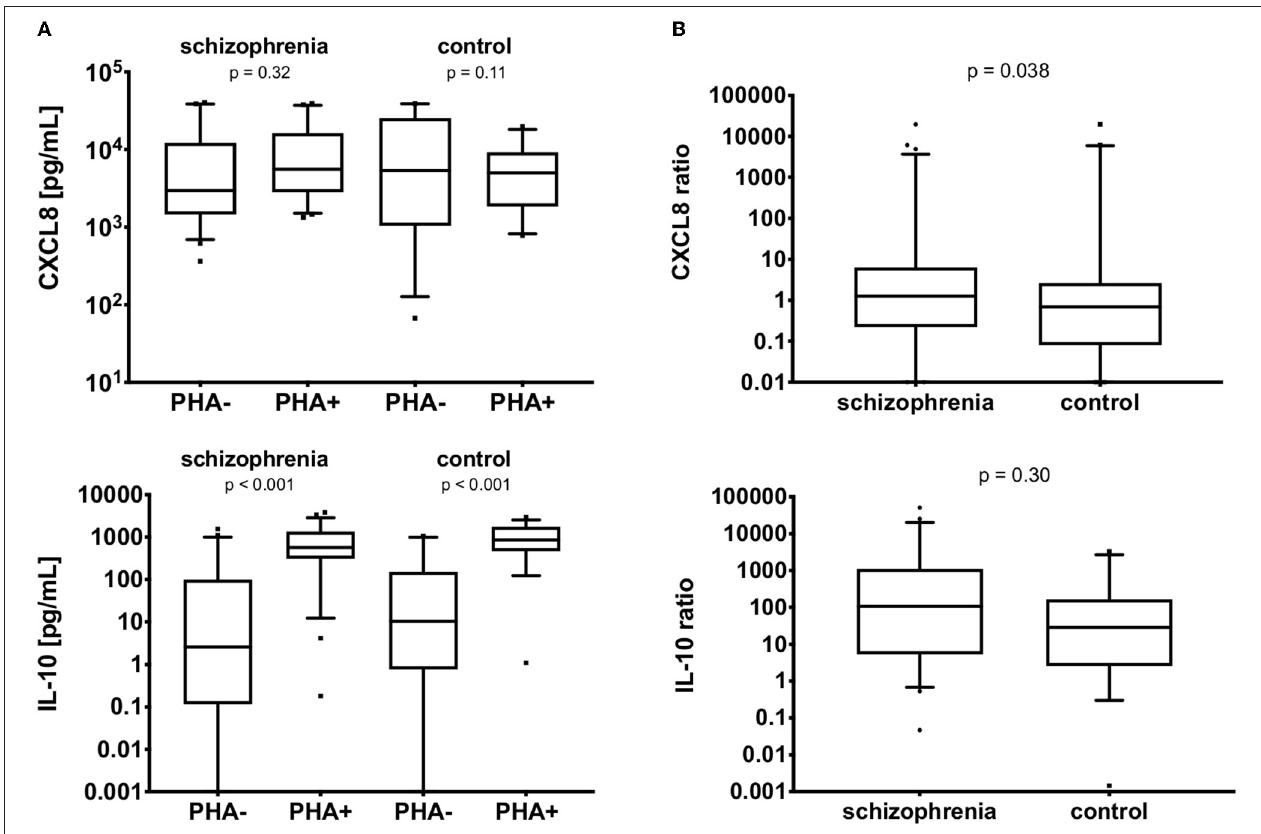
FIGURE 2 | (A) In vitro CXCL8 and IL-10 production in non-PHA (PHA–) and PHA-stimulated (PHA + ) PBMCs. Vertical lines represent 95% CI, black boxes represent means. (B) Ratios of in vitro CXCL8 and IL-10 production in non-PHA (PHA–) and PHA-stimulated (PHA + ) PBMCs. The boxes extend from 25 to 75th percentiles, the lines in the middle of the boxes represent medians. The whiskers extend from 10 to 90th percentiles.